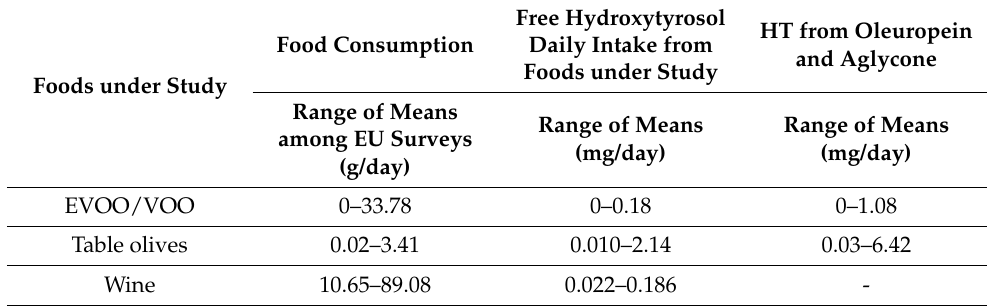
Table 6. Extra Virgin Olive Oil (EVOO)/ Virgin Olive Oil (VOO), table olives and wine (according to levels 3–6 of the FoodEx2 classification system for the adult population) consumption and free hydroxytyrosol daily intake for adult consumers (18–64 years) based on the EFSA Comprehensive European Food Consumption Database.